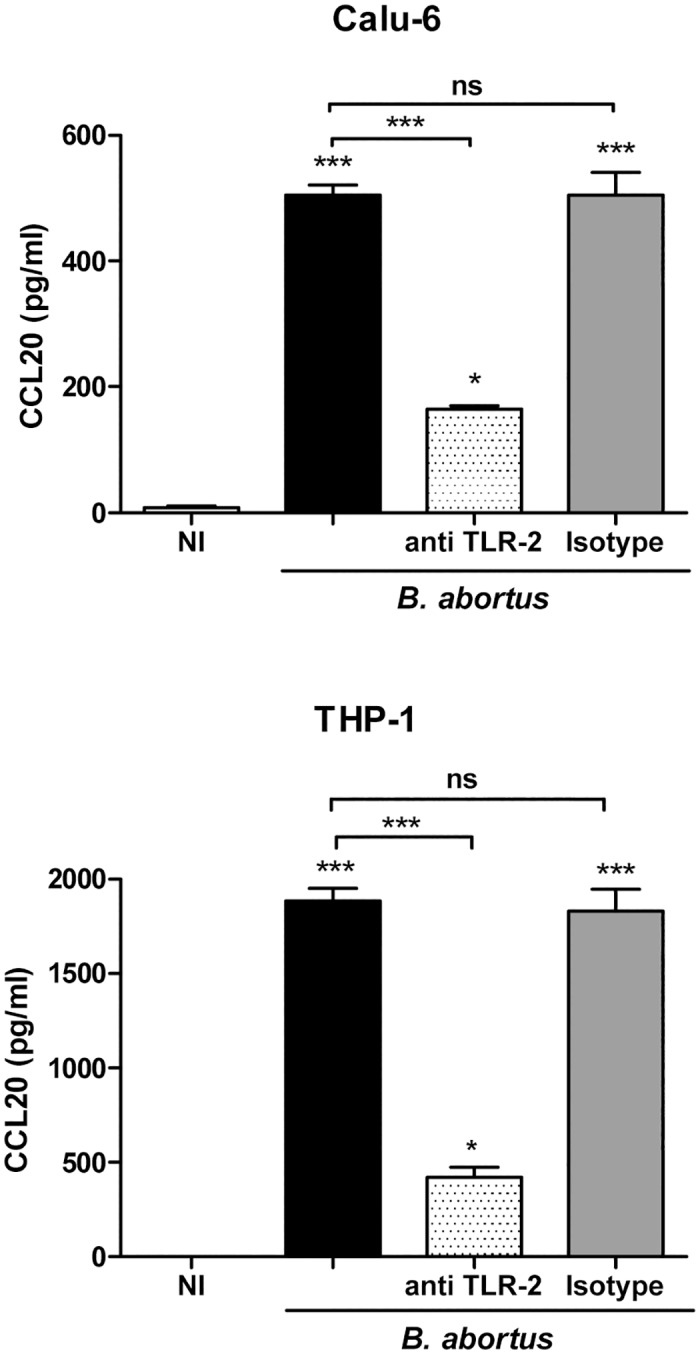
TLR2 recognition mediates CCL20 secretion by B. abortus-infected bronchial epithelial cells and monocytes.Calu-6 and THP-1 cells were preincubated with a neutralizing anti-TLR2 antibody or an isotype control for 1 h at 37°C before infection with B. abortus. Culture supernatants were harvested at 24 h p.i. to measure CCL20 by ELISA. Data are mean ± SEM of CCL20 levels measured in three independent experiments. Asterisks indicate statistical significant differences (*, p < 0.05; ***, p < 0.001) as compared to non-infected cells (NI) (ANOVA followed by Tukey’s Multiple Comparison test).